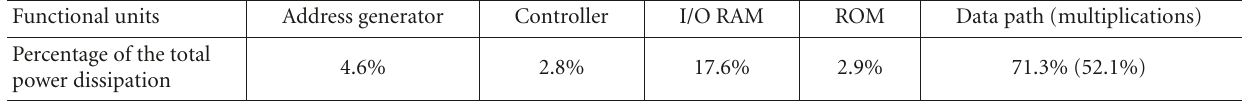
Table 5: Power dissipation percentage for di ff erent functional units in the CBT processor.